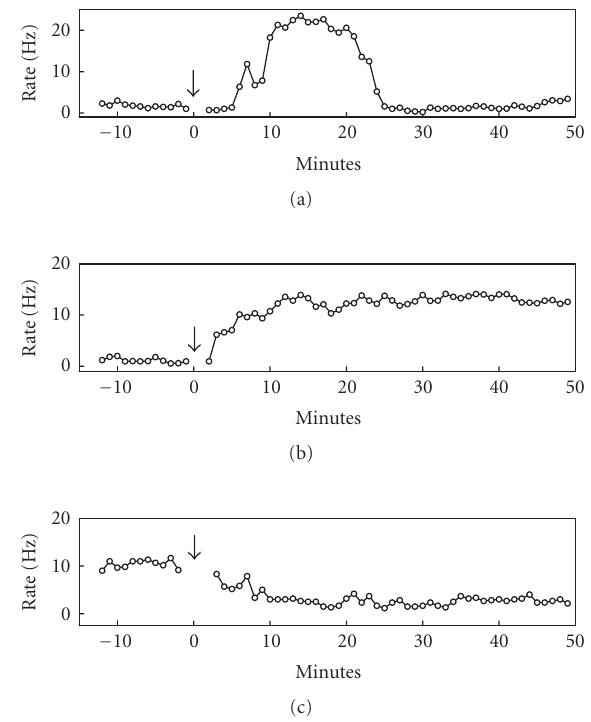
Figure 2: Examples of MA e ff ect on unit activity. These examples show three basic patterns of unit activity change following MA in- jection. (a) An example that shows transient elevation of firing rate. (b) An example that elevated its firing rate without transient eleva- tion. (c) An example that decreased its firing rate without transient elevation. The units in (a), (b) were recorded from awake rats and the unit in (c) was recorded from an anesthetized rat. The arrows indicate the time of MA